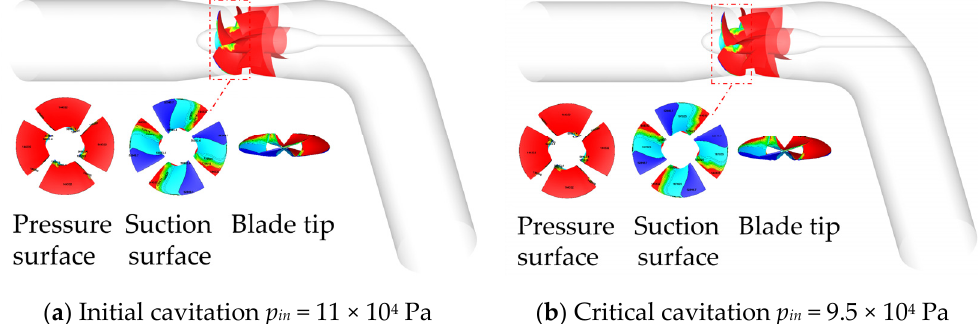
Figure 19. Flow condition Q = 234 L/s pressure distribution cloud diagrams.